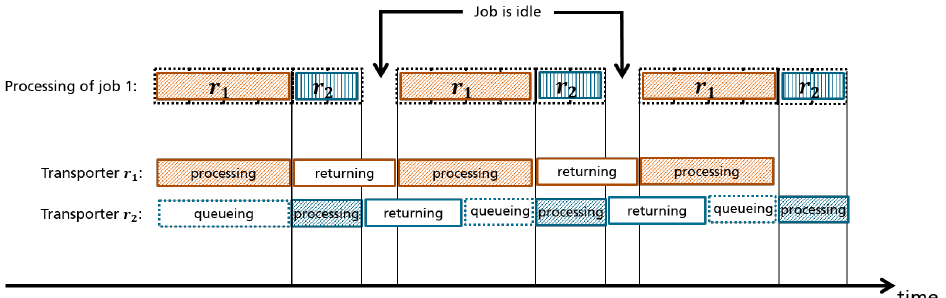
Figure 2. Example of two transporters relaying each other to process a job. The job processing stops while both transporters are in their return